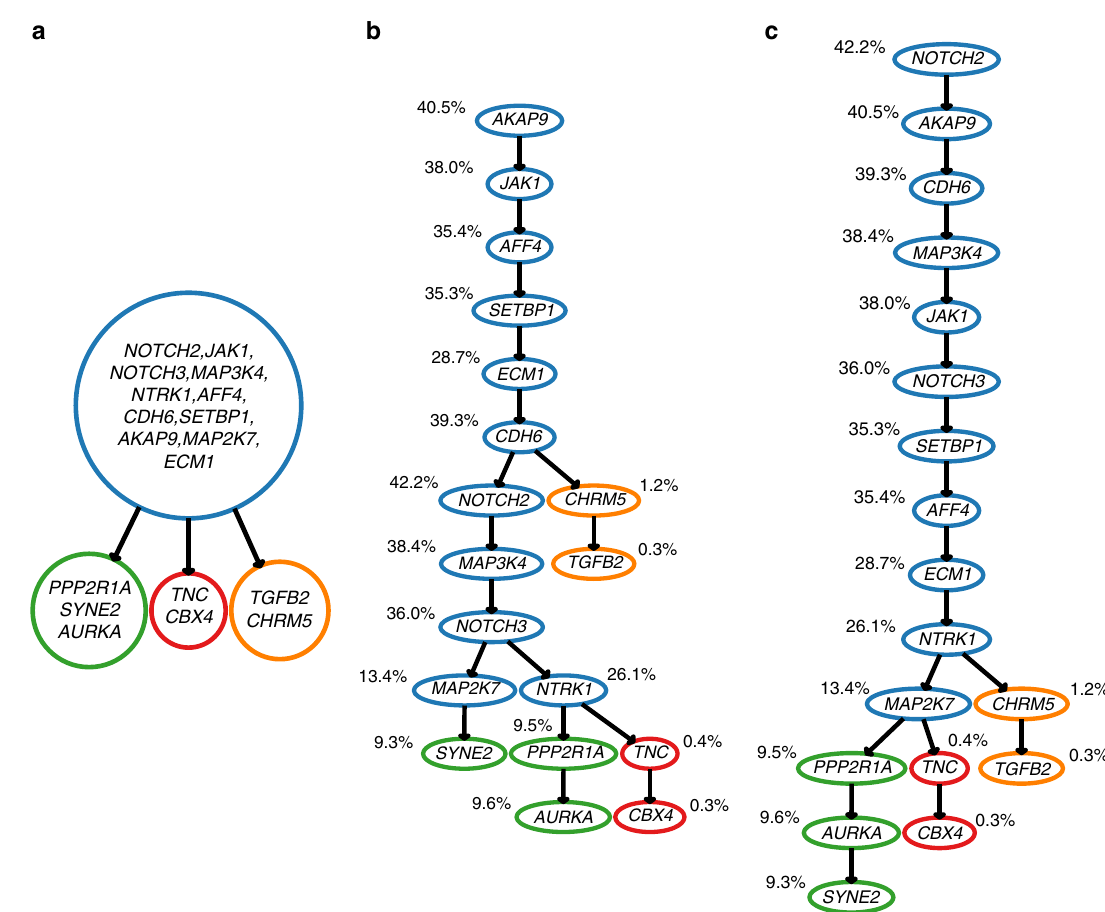
Fig. 7 Mutation histories inferred from bulk (targeted sequencing with the average depth of coverage ∼ 100,000×) and single-cell (16 cells) data for a patient with triple-negative breast cancer from ref. 38 : a clonal tree implied by hierarchical clustering from the original study 38 . Clustering was performed based on the pro fi les of several hundreds of mutations and four populations of cancerous cells were detected. In the same study, a subset of mutations was selected from each cell population and each of them is listed in the label of the corresponding population. b Mutation tree inferred with SCITE 28 . The colouring scheme follows the colouring used in the clonal tree. Mutations are annotated with the VAFs observed in the bulk sample. c Mutation tree inferred with B-SCITE from the combined single-cell and bulk data. B-SCITE infers highly similar branchings as in the clonal tree and also fi nds a mutation ordering that is in congruence with the bulk VAFs. B-SCITE mutation trees can be compressed to clonal trees (Supplementary Fig.